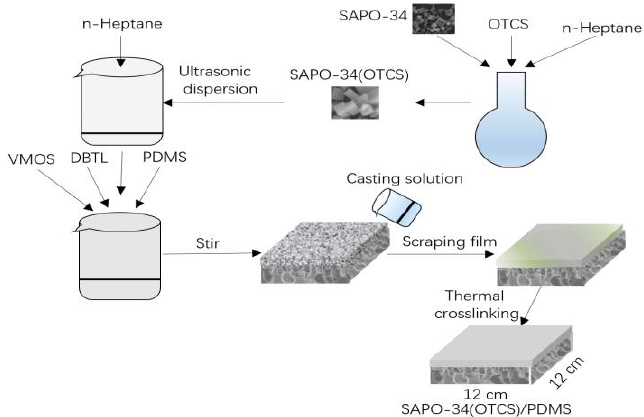
Figure 1. Illustration of preparation of SAPO-34 (OTCS) membranes.